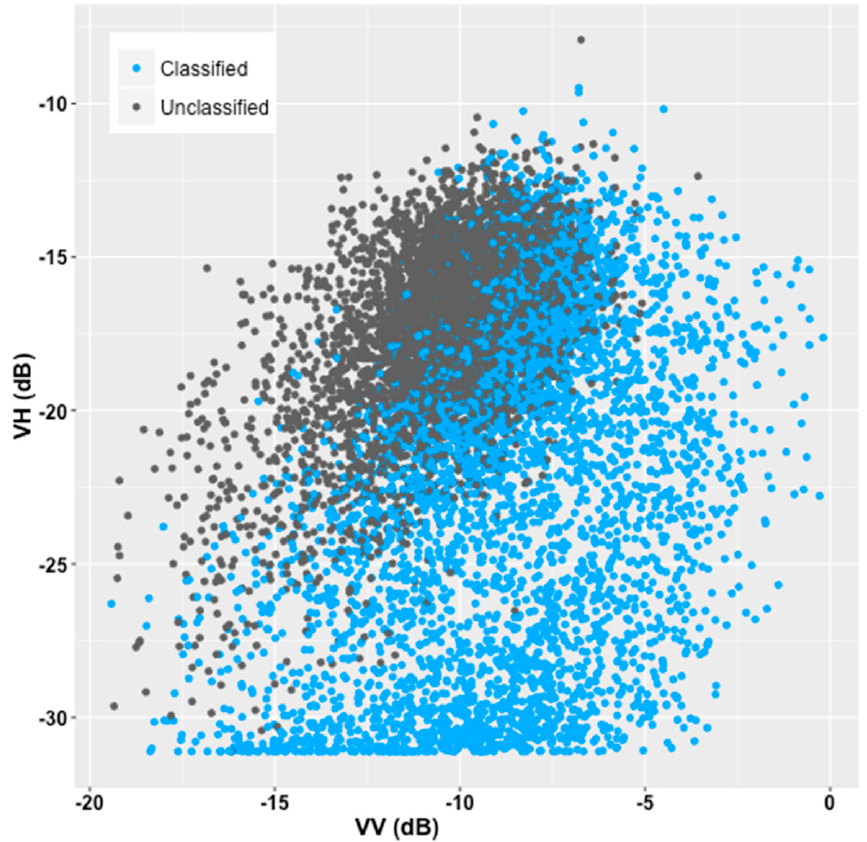
Figure 8. Scatterplot of VV and VH polarised dB backscatter values over vegetated water bodies for 11 May 2018.